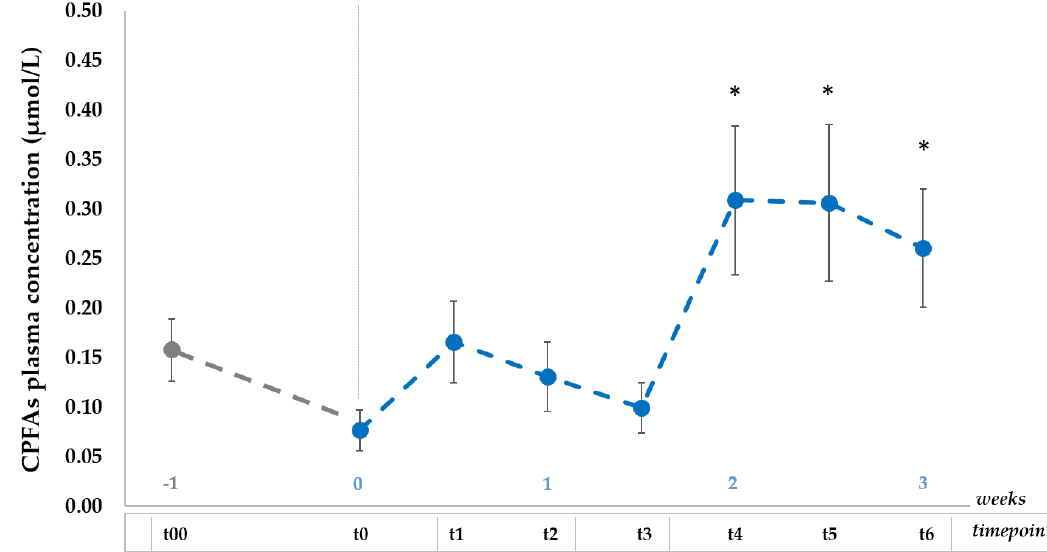
Figure 3. Plasma CPFAs mean concentrations ( µ mol / L, mean ± SEMs) over time for all the subjects ( n = 10) consuming daily portions of GP and whole cow milk for three weeks after 1 week of restricted CPFAs diet (baseline t00 and washout t0); data are expressed as mean ± SEM; * p < 0.05 after paired samples T-test between each timepoint (t1, t2, t3, t4, t5, t6) vs. t0. CPFAs: cyclopropane fatty acids; it refers to the sum of two isomers, namely dihydrosterculic acid (DHSA) and lactobacillic acid [20]. Data indicate there was a relatively large inter-subject variation (% CV) in plasma CPFAs levels, falling in the range between 60–90% at each timepoint.